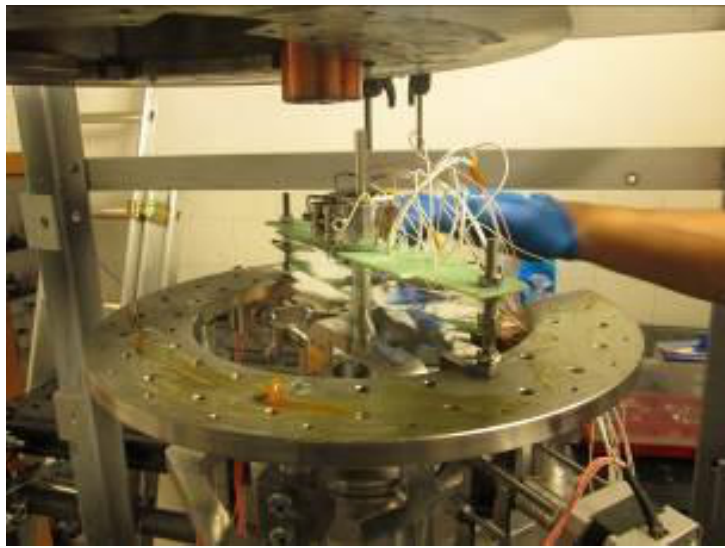
Figure 8. Sensors of the test rig scheme.